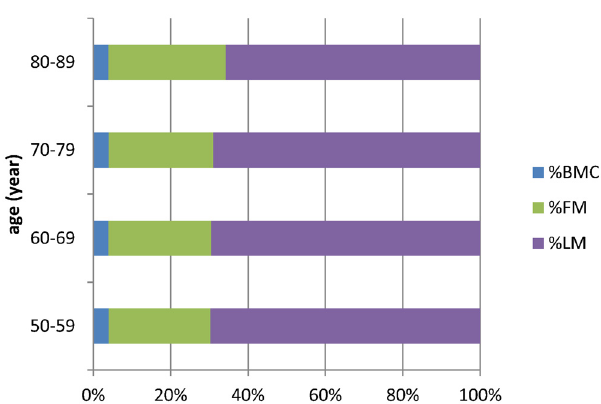
Fig 2. The proportion of body composition change in different age group.